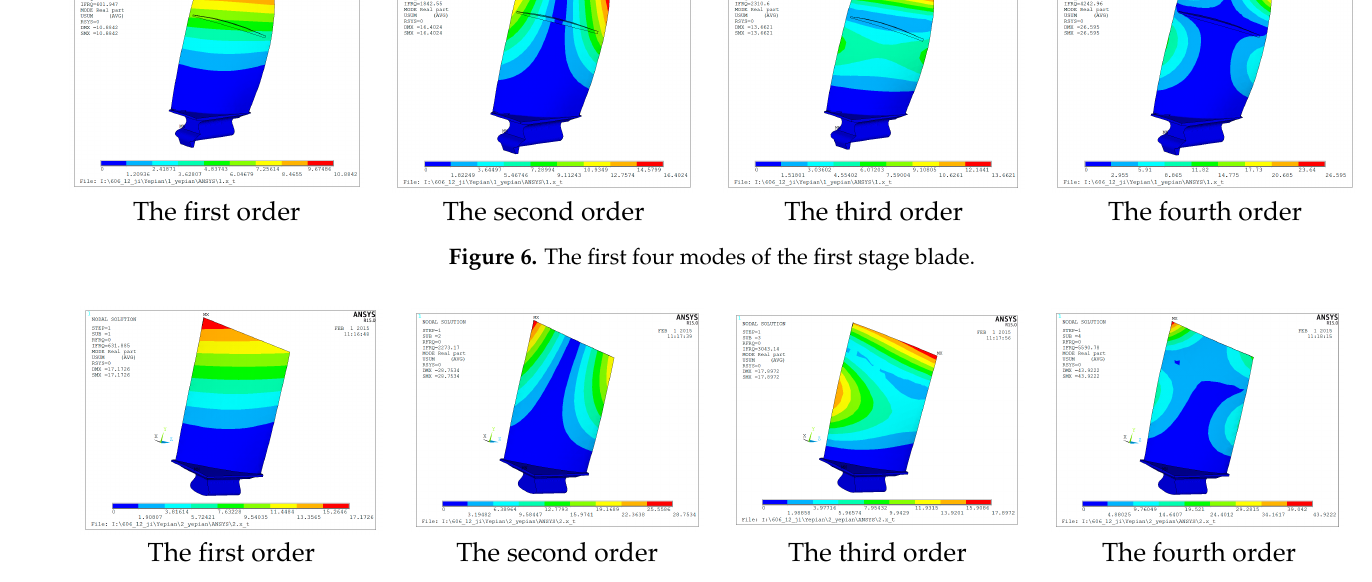
Figure 7. The first four modes of the second stage blade.